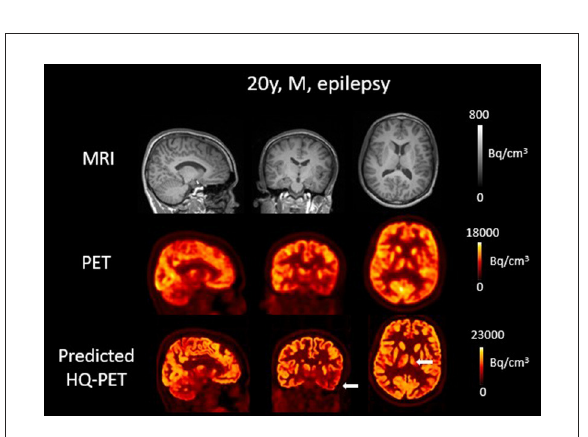
FIGURE7 Brain T1w MRI and clinical [ 18 F]FDG PET as well as predicted high-quality (HQ) PET (predicted by the network developed in this work) from one patient with drug-resistant epilepsy. Images are displayed using radiological conventions (subject’s left on the right) and white arrows are used to highlight areas of hypometabolism. The first two rows show images from the scanner and the third row shows the AI-enhanced high-quality PET. There was no clear anomaly on the MR but a hypometabolism in the left temporal lobe as well as in the left thalamus on both PET images. Bq, Becquerel cm 3 : centimetres cubed .